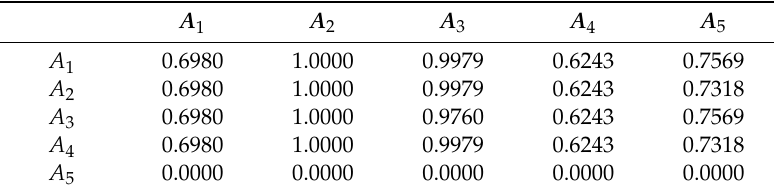
Table 14. Transformed probability of the alternative A 5 to A k .